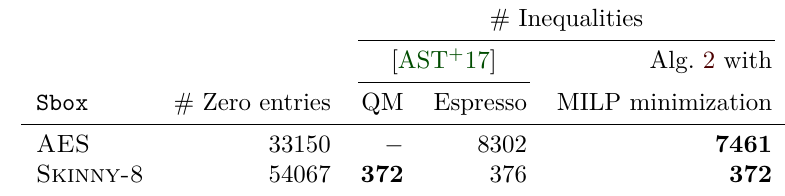
Table 3: Number of inequalities to exclude P for various 8-bit S-boxes with the methods of [AST + 17] and Algorithm